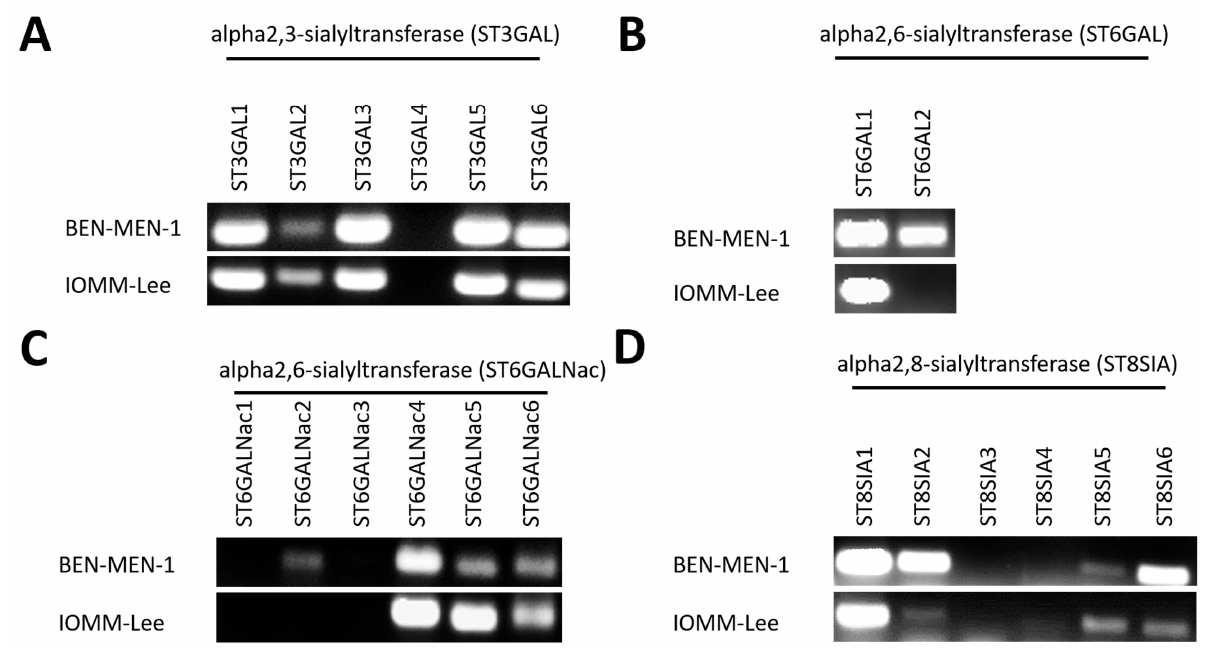
Figure 2. Expression of 20 Sialyltransferases (agarose gel) in BEN-MEN-1 and IOMM-Lee. ( A ): Expression of ST3GAL1–6 . ( B ) : Expression of ST6GAL1–2 . ( C ) : Expression of ST6GALNAC1–6 . ( D ) : Expression of ST8SIA1–6 .